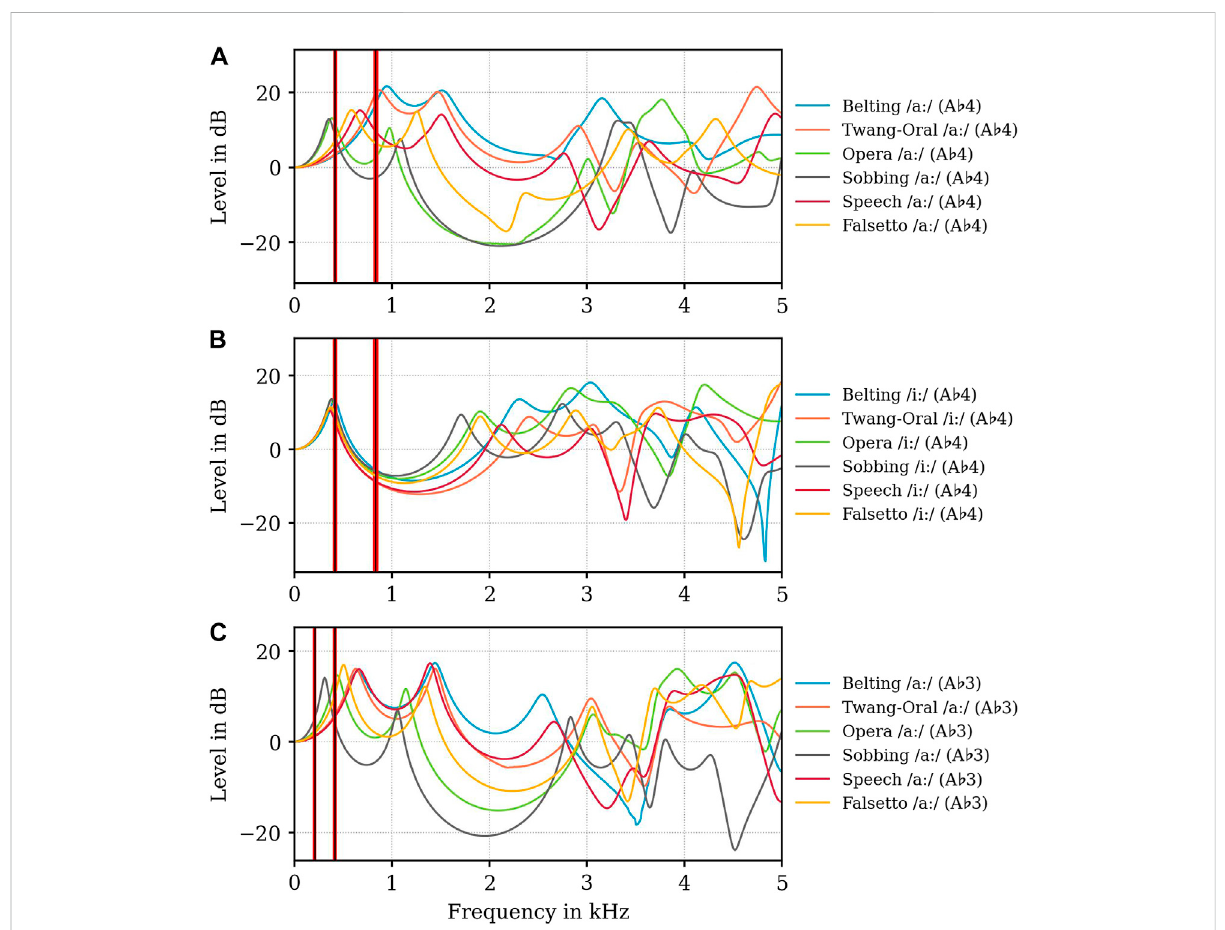
FIGURE 5 Level in dB of Volume velocity transfer functions V l g for all voice qualities according to the legends in all sub- fi gures, for all vowels, and pitch values ( (A) vowel /a ː / A X 4, (B) /i ː / A X 4, (C) /a ː / A X 3). Black vertical lines indicate the nominal fundamental frequencies f o and the second harmonic 2 · f o , respectively. Red vertical lines indicate the range for the fundamental frequency values and the second harmonics audibly produced by the participant during MRI measurements.Because of thehighly reproduced vocal exercise, red linescannot beresolvedin the fi gures and emerge a red